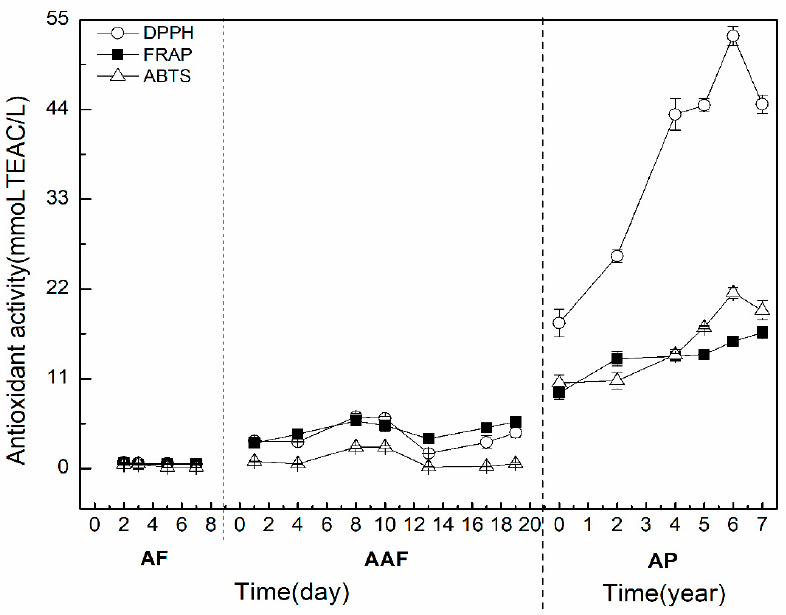
Figure 3. Total antioxidant activity (TAA) and its correlation with TPC and TFC during the brewing process of ZAV. AF: alcohol fermentation, AAF: acetic acid fermentation, AP: aging process.